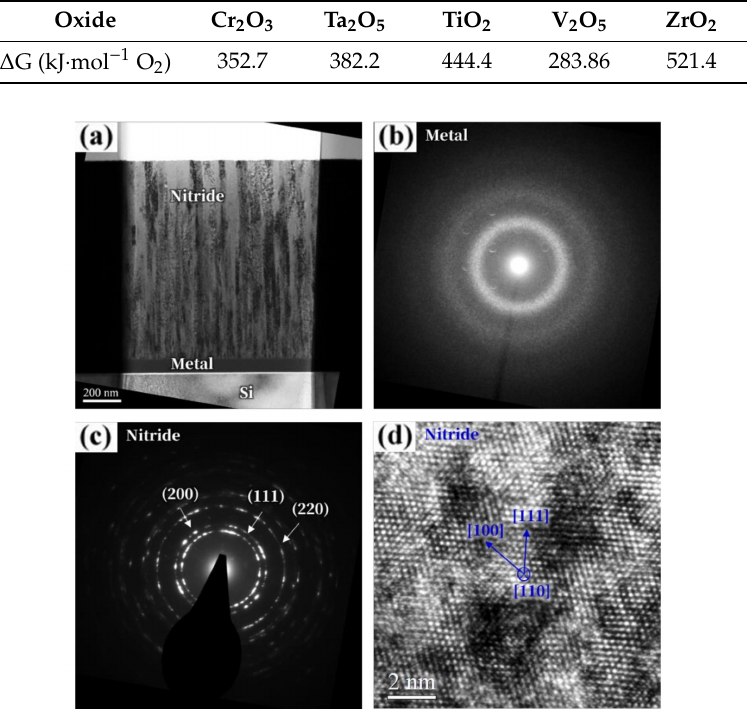
Figure 4. Cross-sectional TEM micrographs of the as-deposited (CrTaTiVZr)N coatings. ( a ) bright-field image, ( b ) SAD pattern of the metal interlayer, ( c ) SAD pattern of nitride layer, ( d ) HRTEM lattice